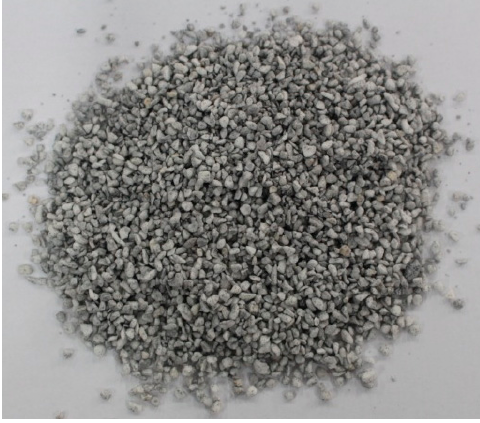
Figure 10. Appearance of TD-LA/EP-AP.